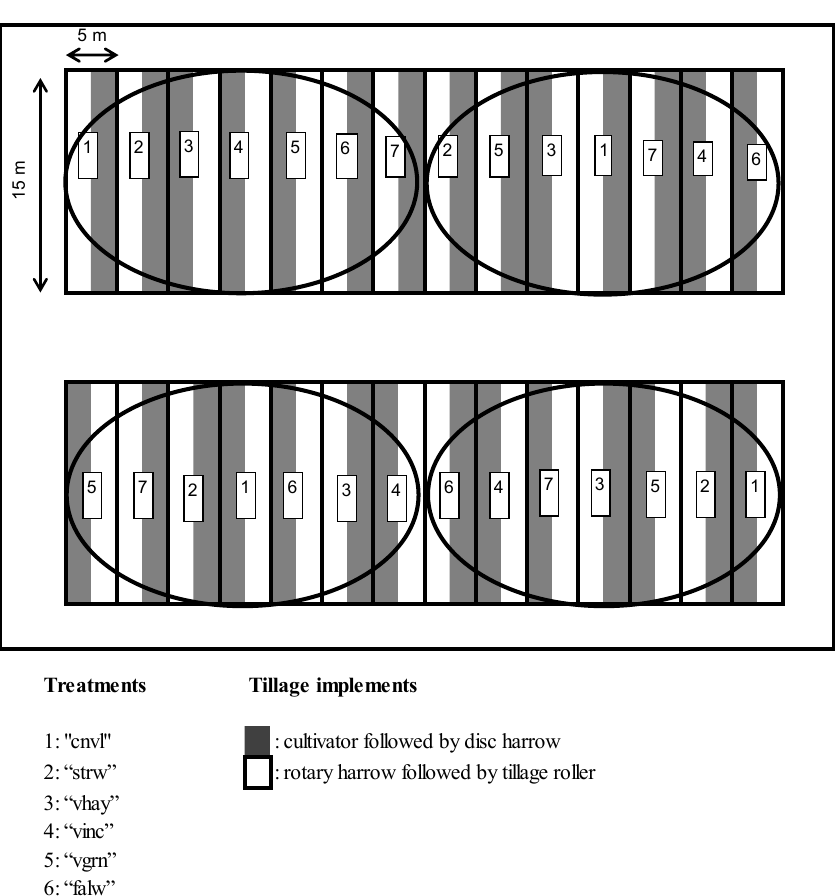
Figure 3. Drawing showing the arrangement of plots in each of the two adjacent fields where the rotation experiment took place. Numbers 1–7 indicate the seven treatments, which were the main plots, and which were grouped in four blocks. The explanation of treatment abbreviations is given in the text.